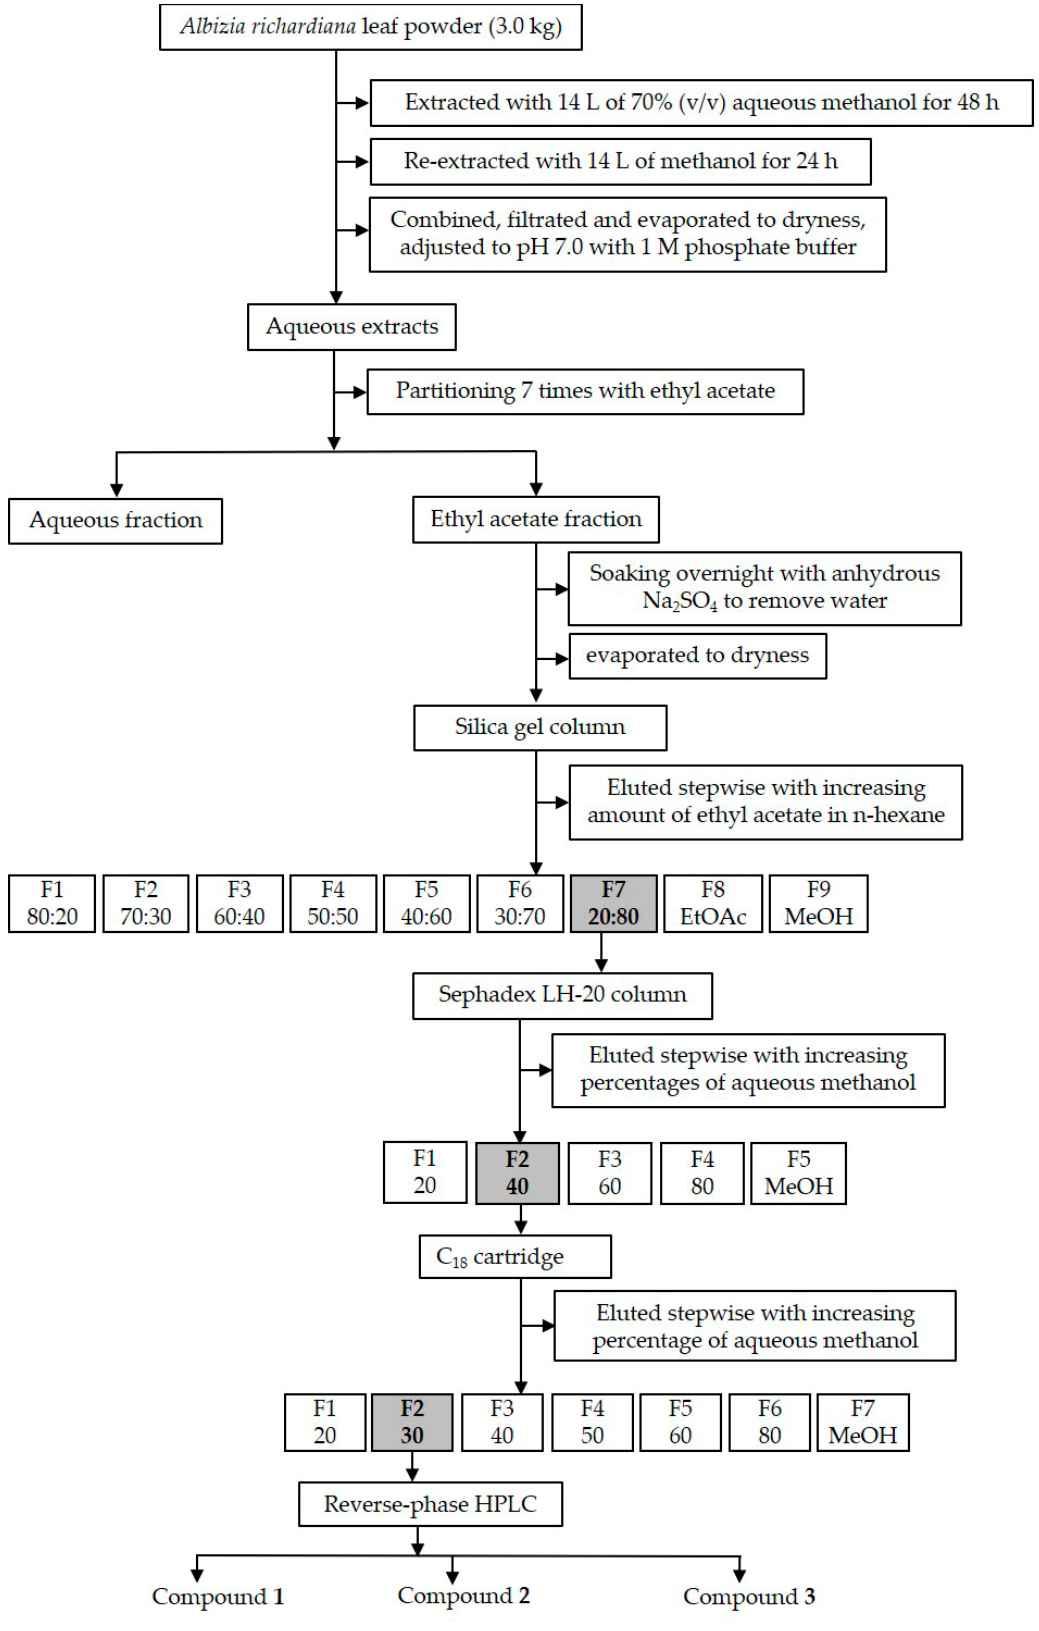
Figure 1. Extraction procedure and purification of compound 1 , 2 , and 3 (4,5-dihydrovomifoliol, 3-hydroxy-5 α ,6 α -epoxy- β -ionone, and 3-(2-hydroxyethyl)-2,4,4-trimethyl-2cyclohexen-1-one).